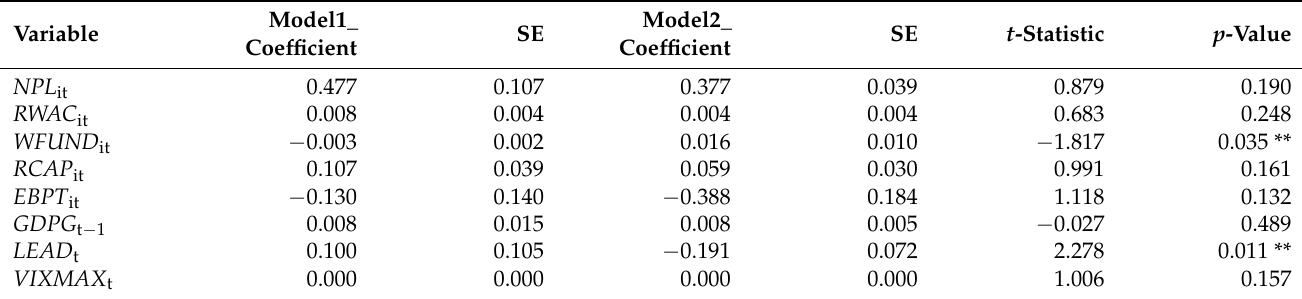
Table A14. Comparison of pre-crisis (1) and post-crisis